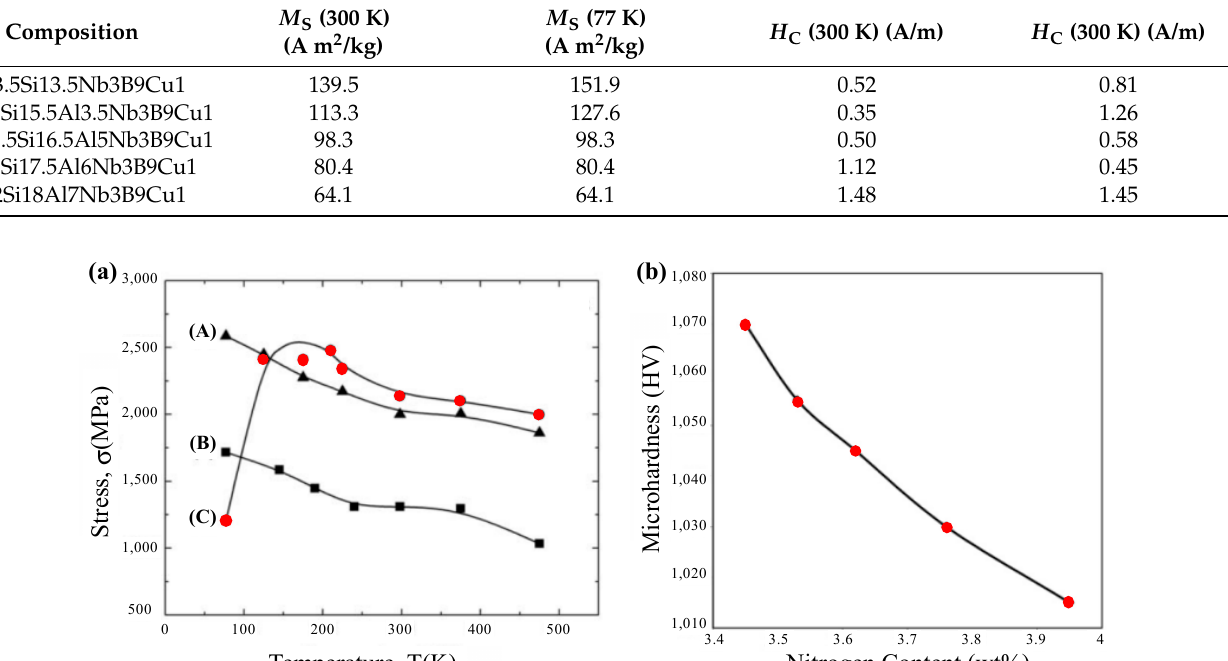
Figure 22. ( a ) Tensile fracture stresses of Ni72P18B7Al3(A), Ni49Fe29P14B6Al2(B), and Fe76P16C4Si2Al2(C) (specimens of 0.025 mm thickness). ( b ) Variation of microhardness values of Fe-18Cr-4Mn-xN amorphous alloy with respect to nitrogen concentration, adapted with permission from Ref. [154] 2009, Elsevier.